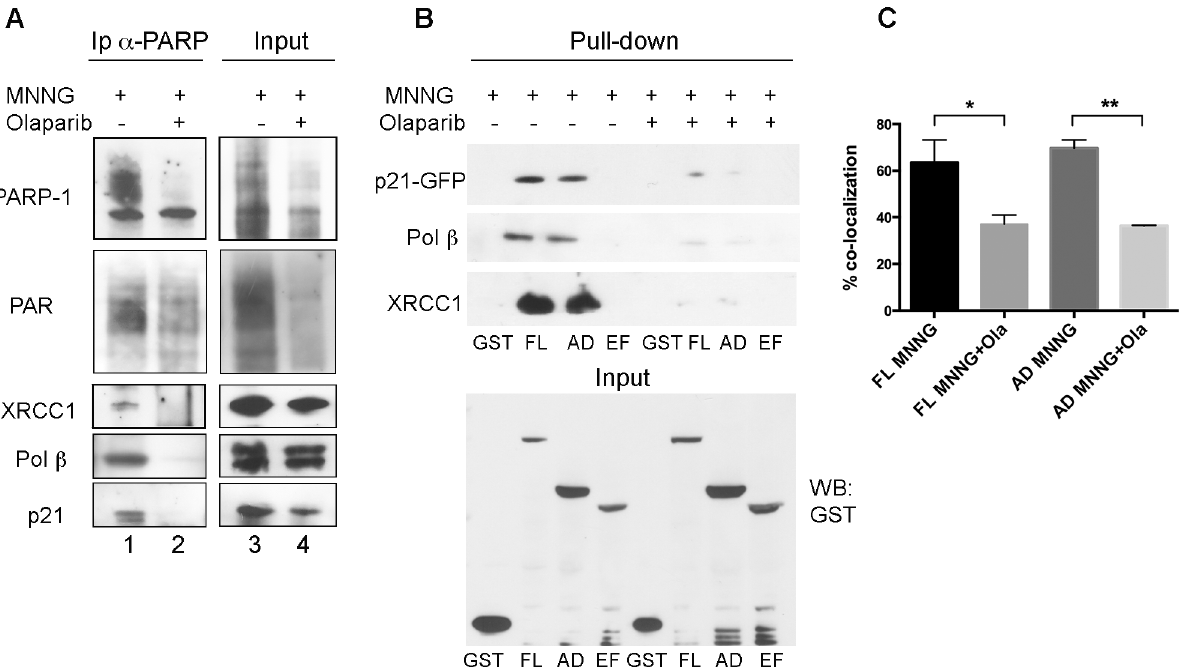
Fig 4. Interaction of p21 with PARP-1 is reduced by Olaparib. ( A ) Immunoprecipitation of p21 with monoclonal anti-PARP-1 F1-23 antibody from nuclear extracts of LF-1 human fibroblasts treated for 30 min with 25 μ M MNNG alone (MNNG), or pre-treated with 10 μ M Olaparib. Immunoprecipitates were separated by SDS-PAGE and analysed by Western blot for PARP-1, XRCC1, pol ß, or p21. Input shows 10% of total extract before Ip. ( B ) Pull-down of GST- tagged PARP-1 FL, AD, or EF fragments from HeLa cell extracts treated for 30 min with 25 μ M MNNG in the presence, or in the absence of 10 μ M Olaparib. Samples were analysed by Western blot for XRCC1, pol ß, or p21. Input shows 10% of total extract before pull-down. ( C ) Percentage of co-localization of GST-tagged PARP-1 FL, or AD constructs with p21-GFP in HeLa cells after treatment with 100 μ M MNNG, in the presence or in the absence of 10 μ M Olaparib. Chromatin-bound fractions of in situ lysed cells were analysed. Mean values ± S.D. of three independent experiments are